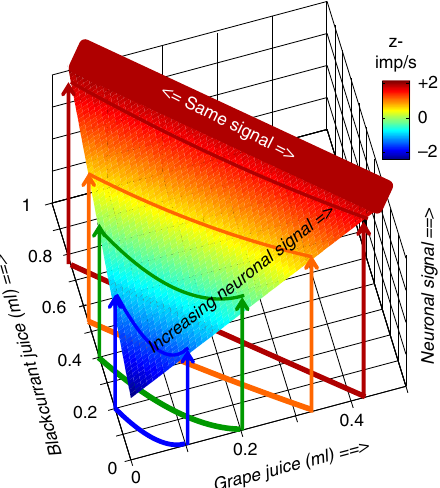
Fig. 7 A scalar neuronal signal for two-dimensional, vectorial bundle choice options. Color-coded intensity of neuronal revealed preference response in orbitofrontal cortex: same signal with equal revealed preference along indifference curves (indicated by same color), increasing signal with increasing behavioral revealed preference across indifference curves (from blue to red). Single neuron, choice between two nonzero bundles (600 trials; z-imp/s: z-scored